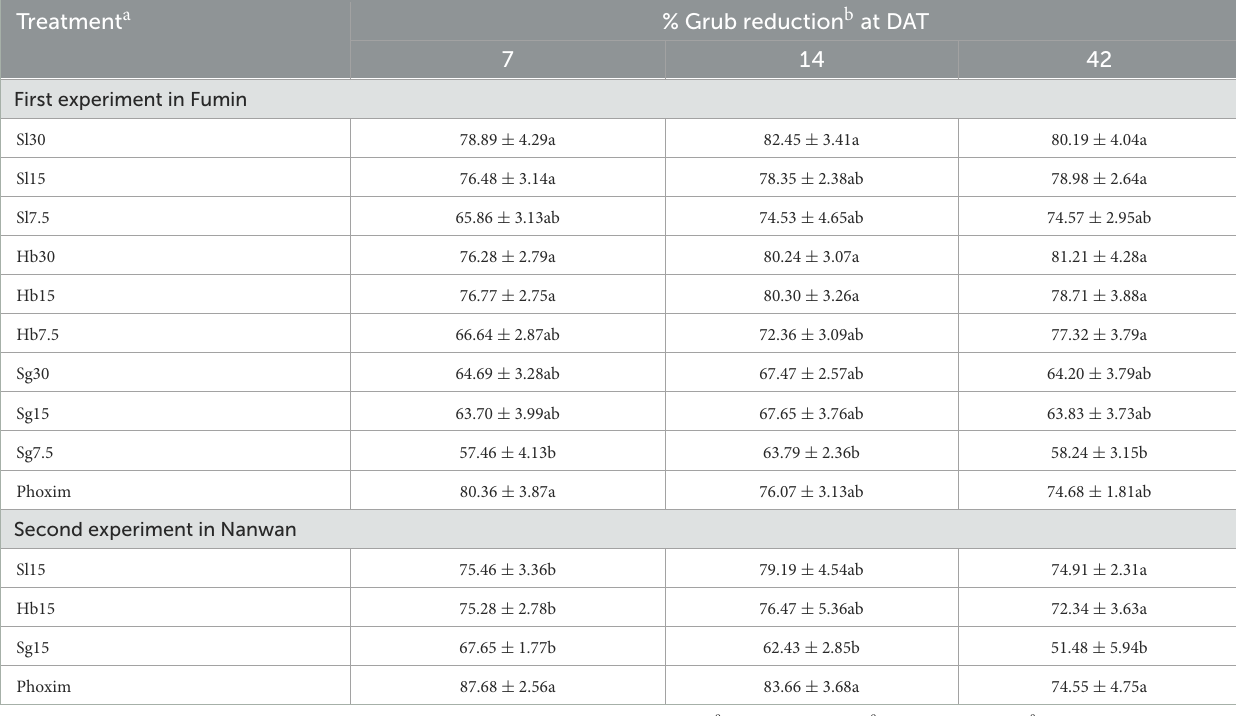
TABLE 1 Percentage reduction in white grubs obtained from different treatments at 7, 21, and 42 days after treatment (DAT) in honeysuckle fields in Fumin (first experiment) and Nanwan (second experiment), Shandong, China. Treatment